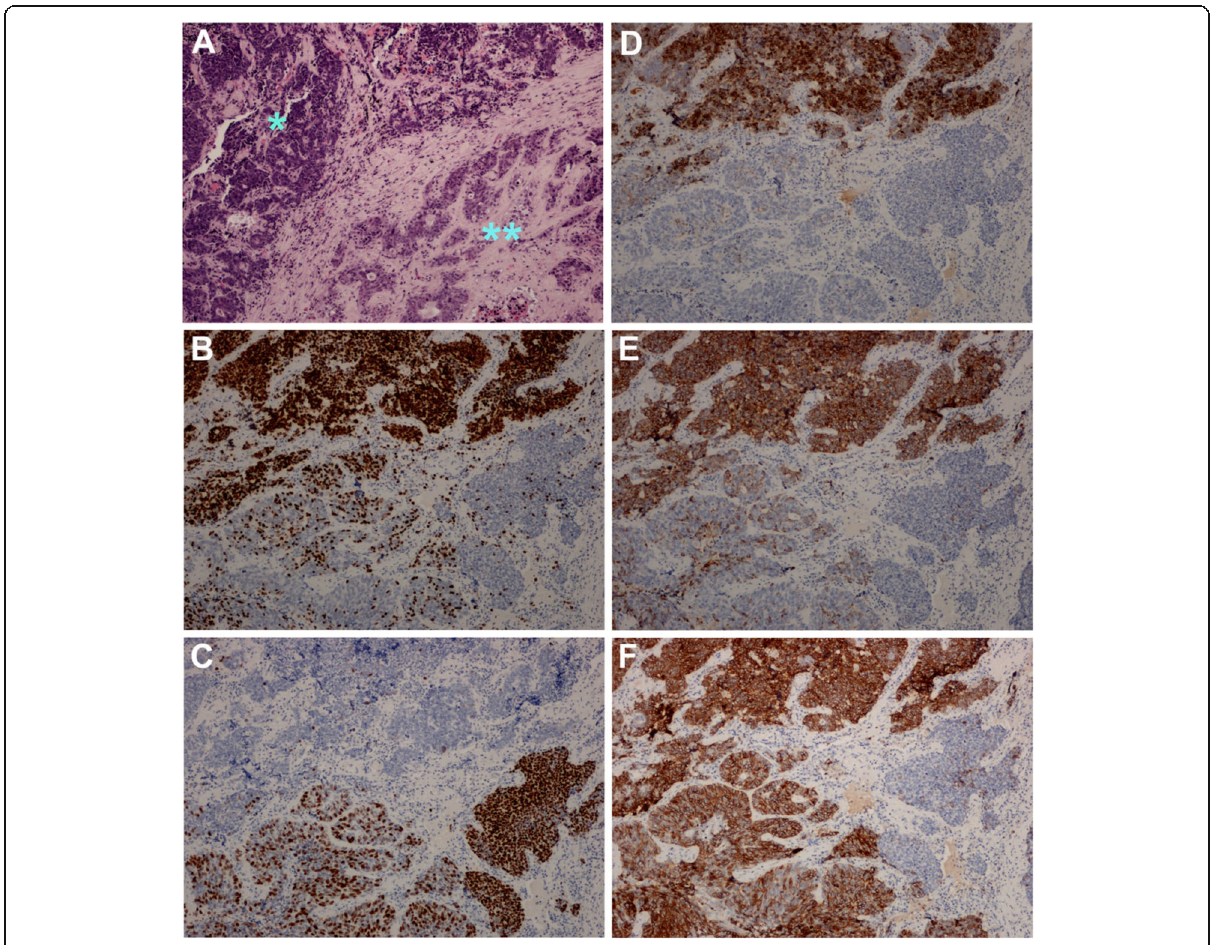
Fig. 4 The photomicrographs show the morphological features and immunohistochemical profile of a tumor exhibiting small cell lung carcinoma (SCLC) morphology transitioning to basaloid carcinoma (B-SqCC) features. A The SCLC characterized by hyperchromatic densely packed cells with scant cytoplasm on the left (*) and pure B-SqCC with hyperchromatic nuclei surrounded by moderate eosinophilic cytoplasm on the right (**). The immunohistochemical stains highlight the transitioning spatial differentiation with B TTF-1 positive staining in SCLC and negative staining in pure B-SqCC and conversely C p40 negative staining in SCLC and strong positive in pure B-SqCC. On the other hand neuroendocrine stains including D Chromogranin, E Synaptophysin and F CD56 are positive in SCLC while pure B-SqCC is either focally positive or is